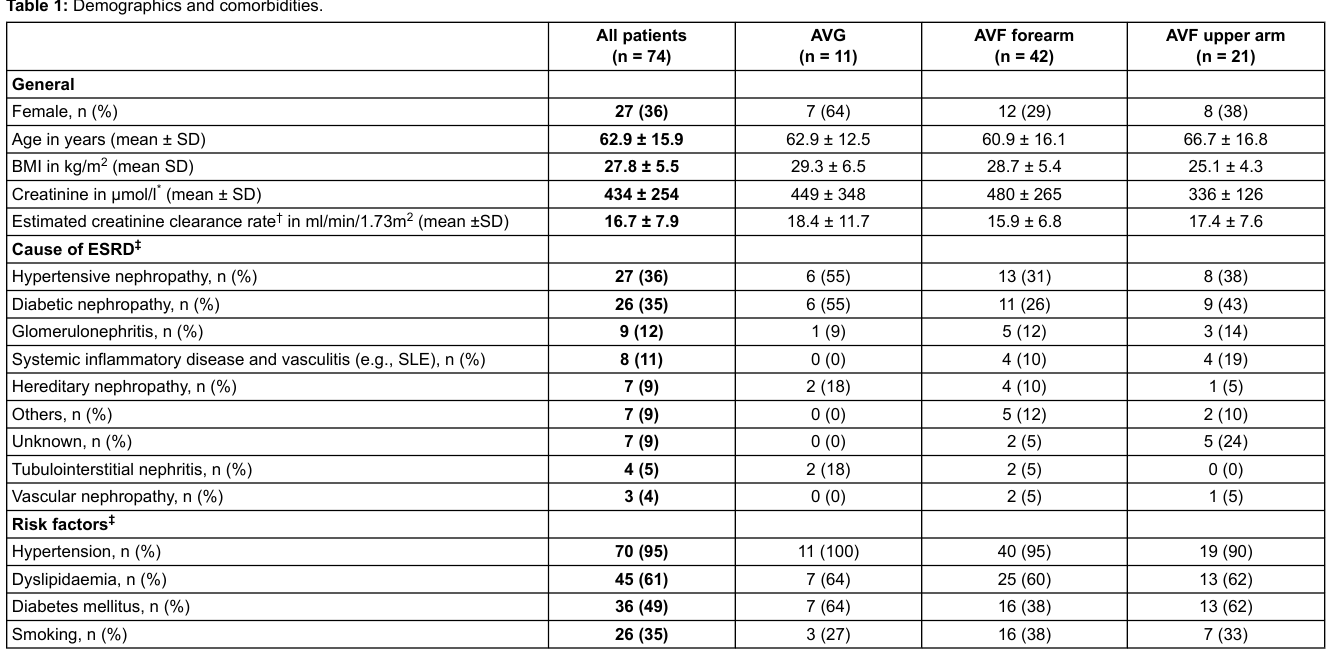
Table 1: Demographics and